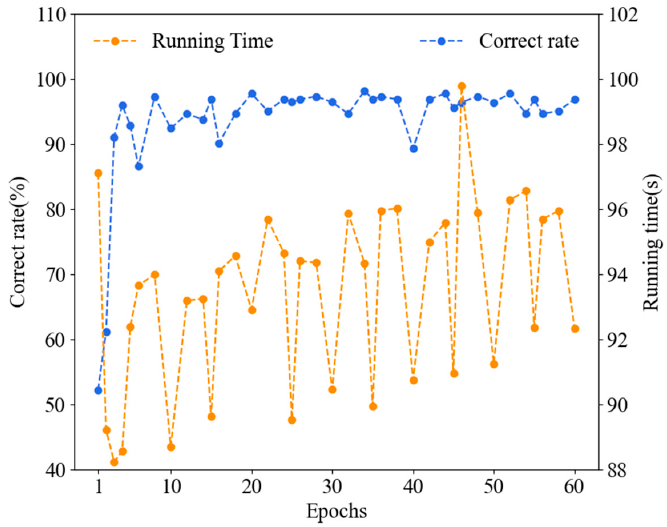
Figure 8. Performances of fault diagnosis based on the VGG-PCA model with different epochs.